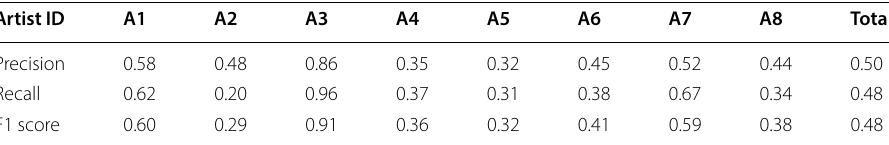
Table 4 Classification performance for the panel